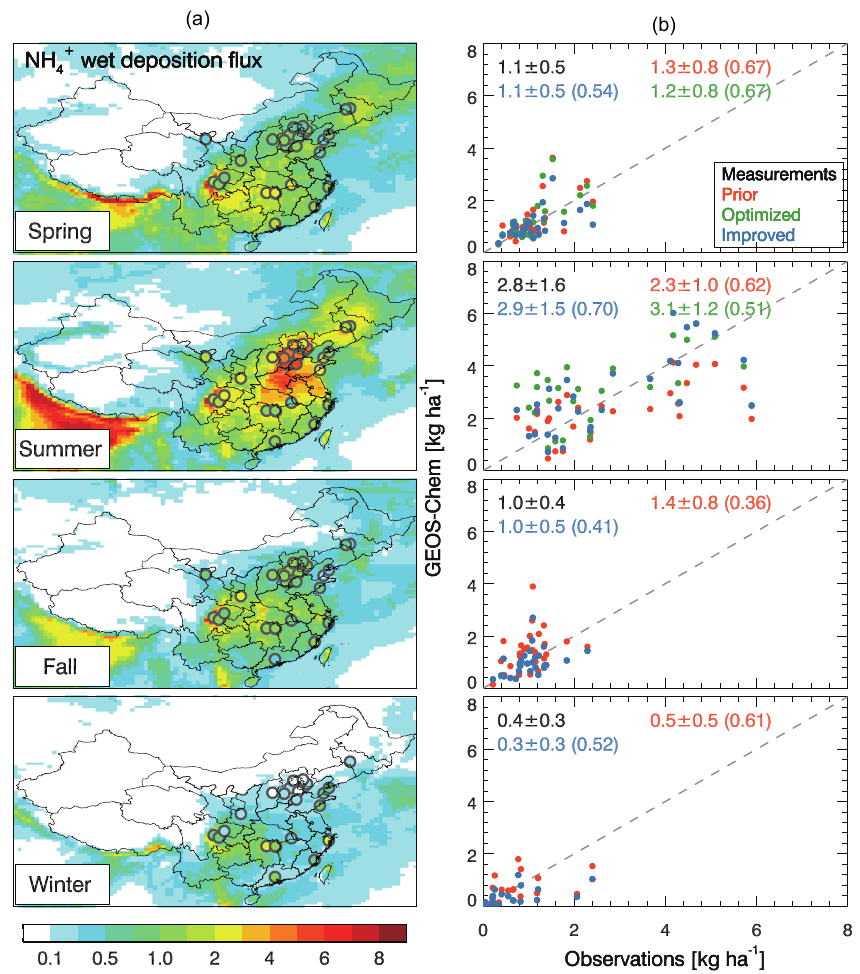
Figure 8. Comparison of simulated vs. measured seasonal mean NH + wet deposition fluxes over China. Spatial distributions (a) and scat- 4 terplots (b) are shown. Values inset are seasonal mean deposition fluxes and standard deviations for measurements (black), and model results with prior REAS v2 (orange), adjoint optimized (green; for spring and summer), and improved bottom-up (blue) NH 3 emissions. The correlation coefficients (values in parentheses) and the 1 : 1 line (dashed line) are also